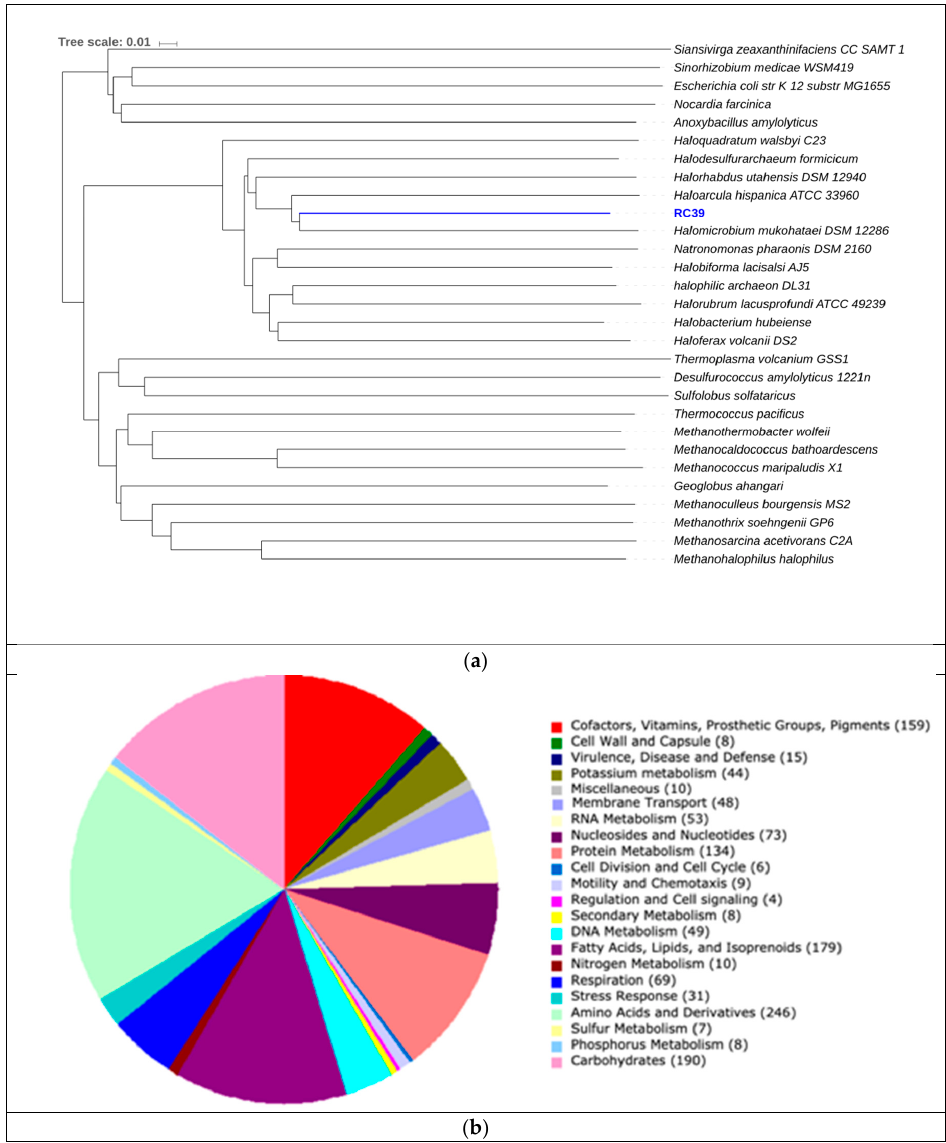
Figure 9. ( a ) Phylogeny for RC39 using AAI. The scale represents the number of amino acid substitutions over time. ( b ) Subsystem category distribution for RC39. The graph represents the number of proteins that were grouped into a specific subsystems; 1366 of 2439 coding sequences were identified to fit into subsystems. This chart was generated using Rapid Annotation System Technology (RAST ).